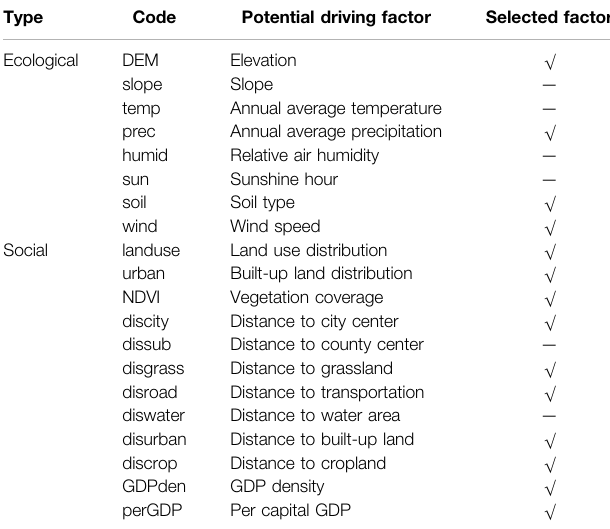
TABLE 5 | Potential and selected driving factors for ES supply, demand, and match